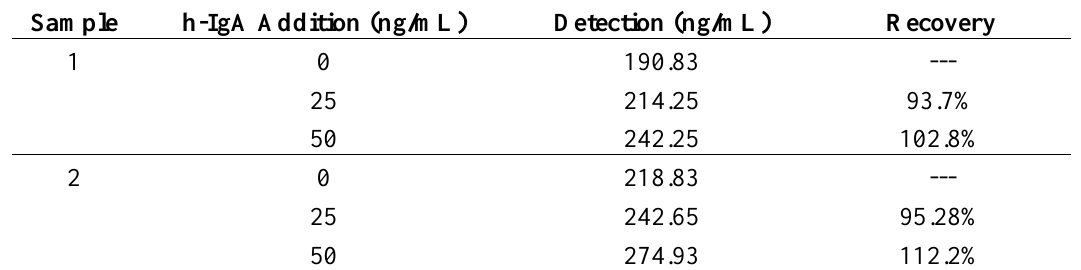
Table 3. Investigation of recoveries for h-IgA in saliva samples by the proposed microwell